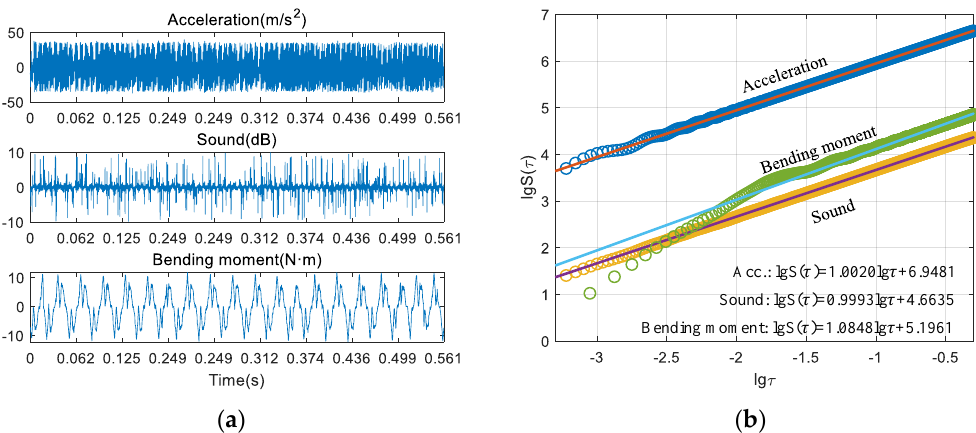
Figure 3. Calculation of the fractal dimension of the stable milling condition. ( a ) aquired signals; ( b ) process of calculating fractal dimension.